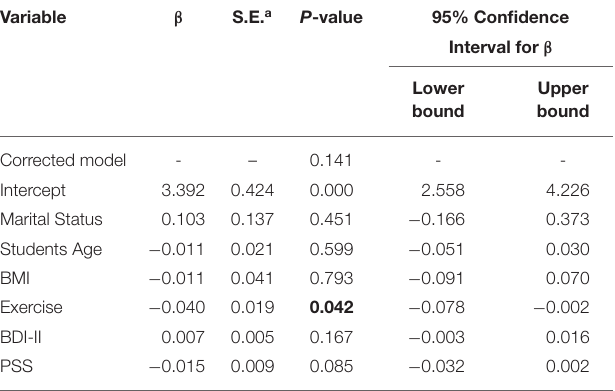
TABLE 4 | General linear model for unhealthy food